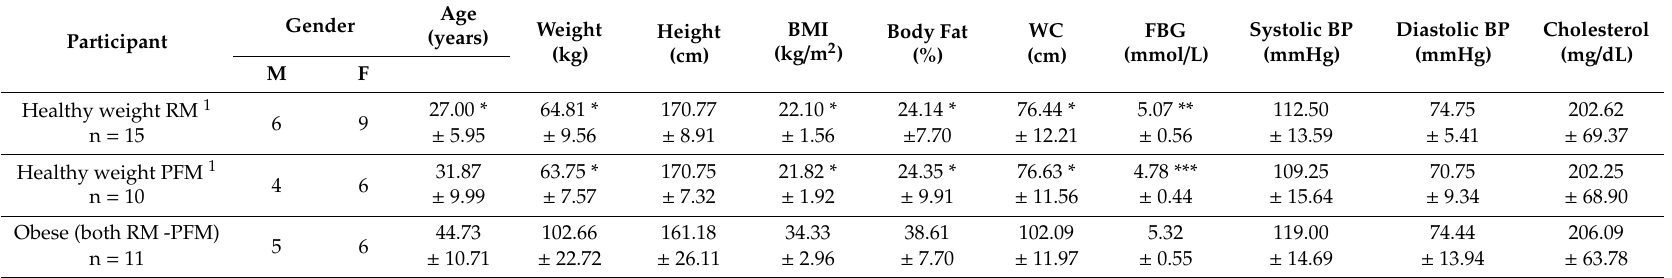
Table 1. Participant characteristics for each group. Presented as the mean ± standard